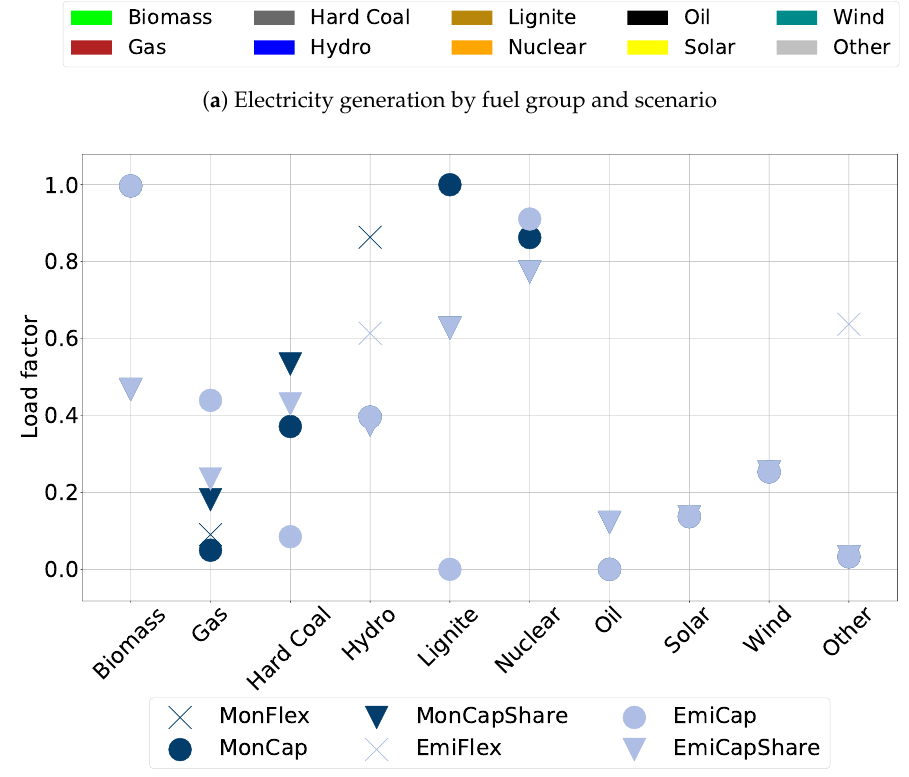
Figure 5. Comparison of electricity generation by fuel group and their average load factor per